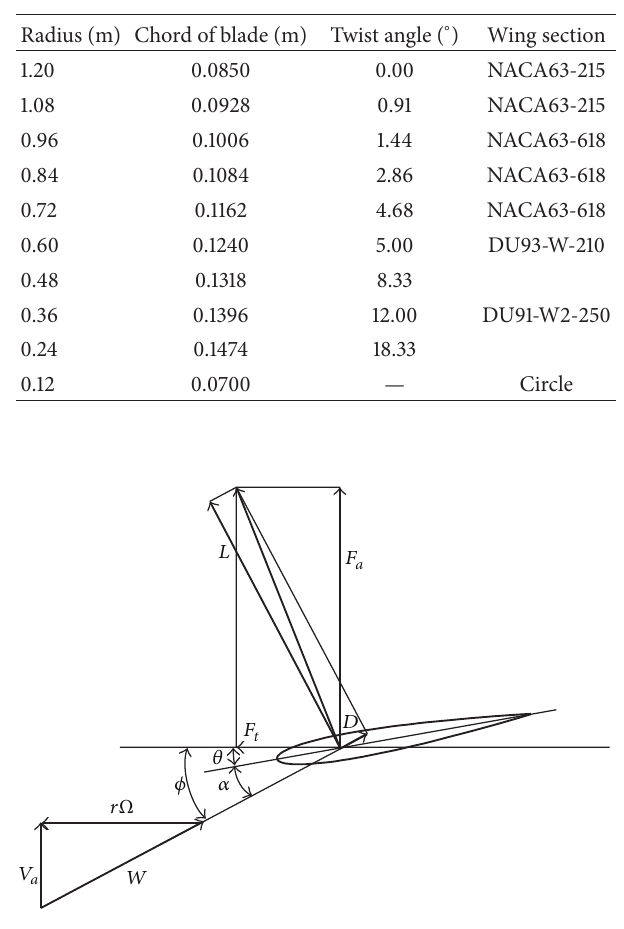
Figure 2: Fluid force acting on a